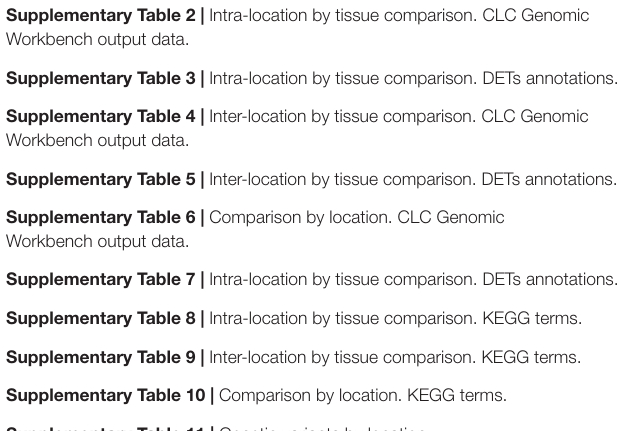
Supplementary Table 8 | Intra-location by tissue comparison. KEGG terms. Supplementary Table 9 | Inter-location by tissue comparison. KEGG terms. Supplementary Table 10 | Comparison by location. KEGG terms. Supplementary Table 11 | Genetic variants by